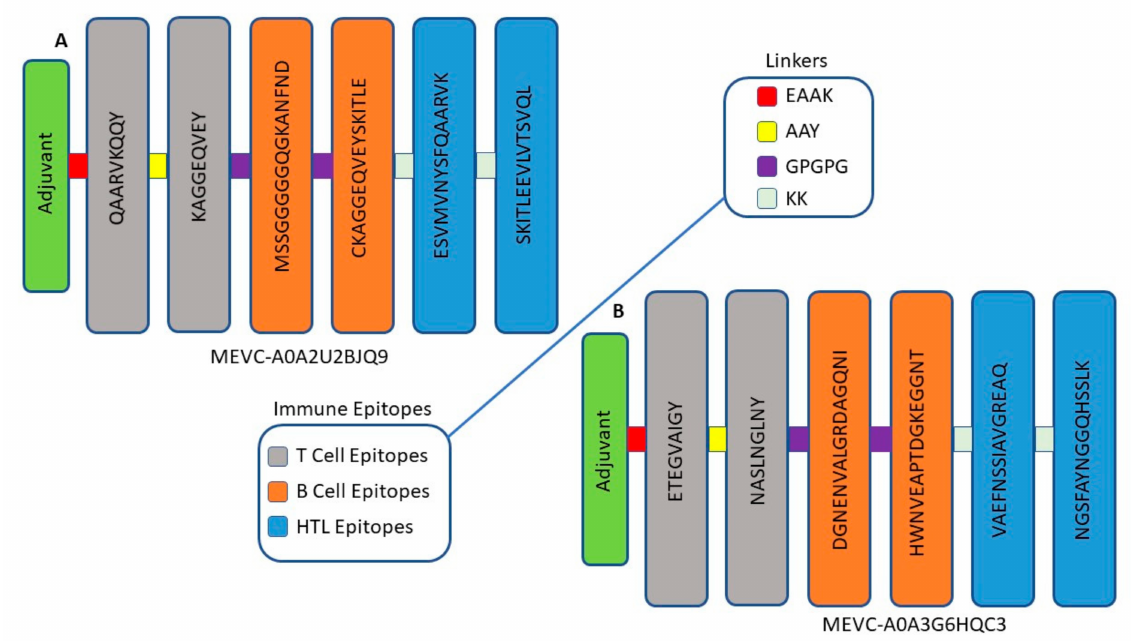
Figure 2. The topographical organization of each MEVC designed against the two target proteins. The different colors represent each type of epitope and linker used in the vaccine design procedure. Figure ( A ) represents the topographical organization of MEVC named (MEVC-A0A2U2BJQ9), while ( B ) represents the topographical organization of MEVC named (MEVC-A0A3G6HQC3) designed against each protein, respectively.